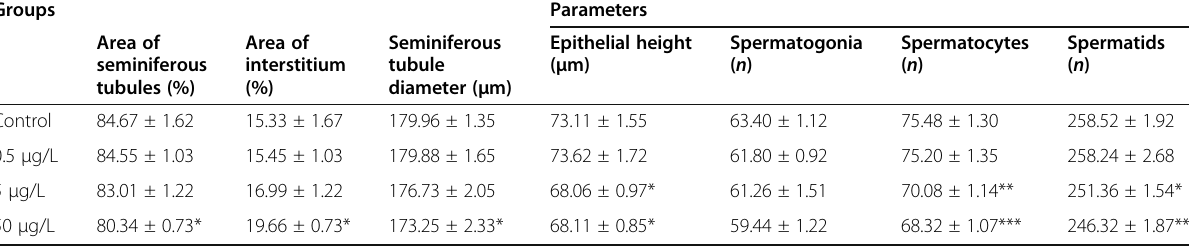
Table 5 Effect of chronic exposure of different concentrations of BPS (0.5 μ g/L, 5 μ g/L, and 50 μ g/L) on planimetry of testis in rats Groups